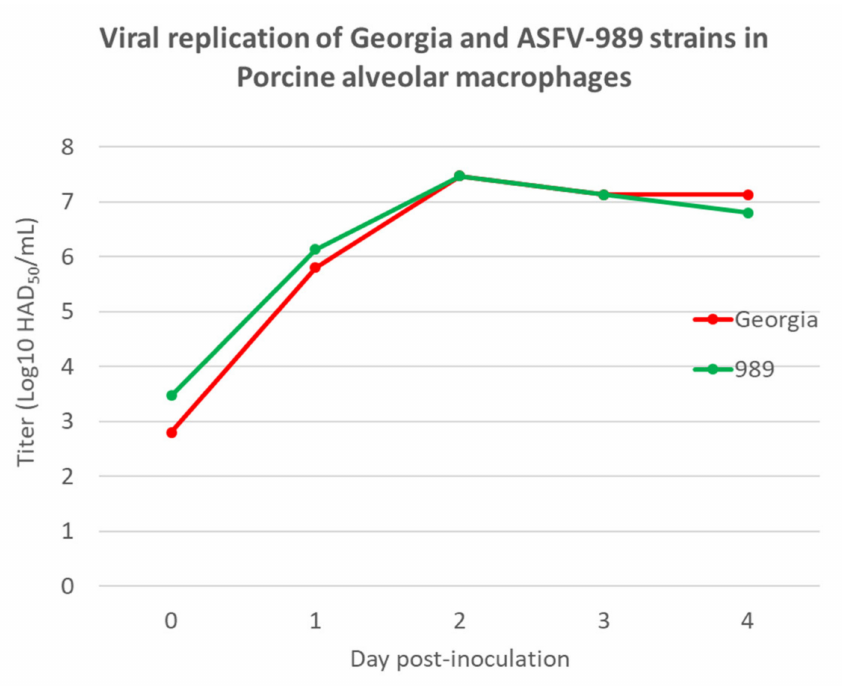
Figure 2. Viral replication of Georgia 2007/1 and ASFV-989 strains in porcine alveolar macrophages (titer in Log10 HAD 50 /mL, time in days